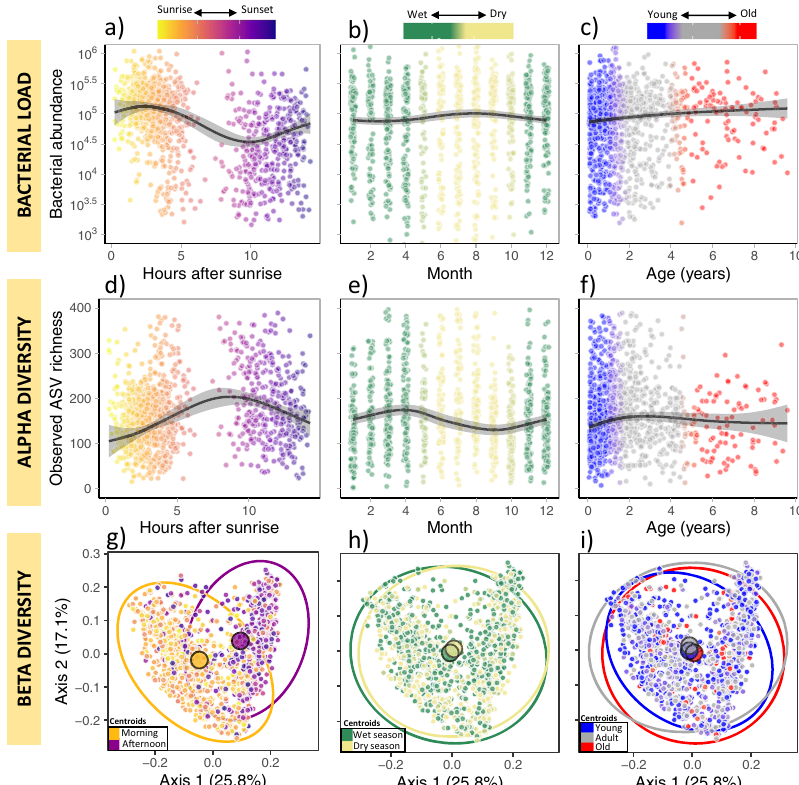
Fig. 2 Temporal trends in gut bacterial load (top), alpha diversity (middle), and beta diversity (bottom) across the day (left), year (centre), and life (right). a – f Smoothed estimates and partial residuals from two GAMMs predicting ( a – c ) bacterial load and ( d – f ) observed ASV richness across the day, year, and life. Shaded area represents 95% CIs. g – i Beta diversity MDS ordination coloured by ( g ) hours after sunrise (orange = morning; afternoon = purple), ( h ) season (green = wet season; yellow = dry season), and ( i ) age (blue = young; grey = adult; red = old). For clarity, samples were grouped into discrete categories to generate 95% CI ellipses and group centroids (large circles), which represent samples collected in the morning fi eld session (< 7 h after sunrise) and afternoon (> 7 h after sunrise), wet (October – April) and dry (May – September) season, and age categories (< 1 years, 1 – 5 years, and >5 years). Source data are provided in the source data fi